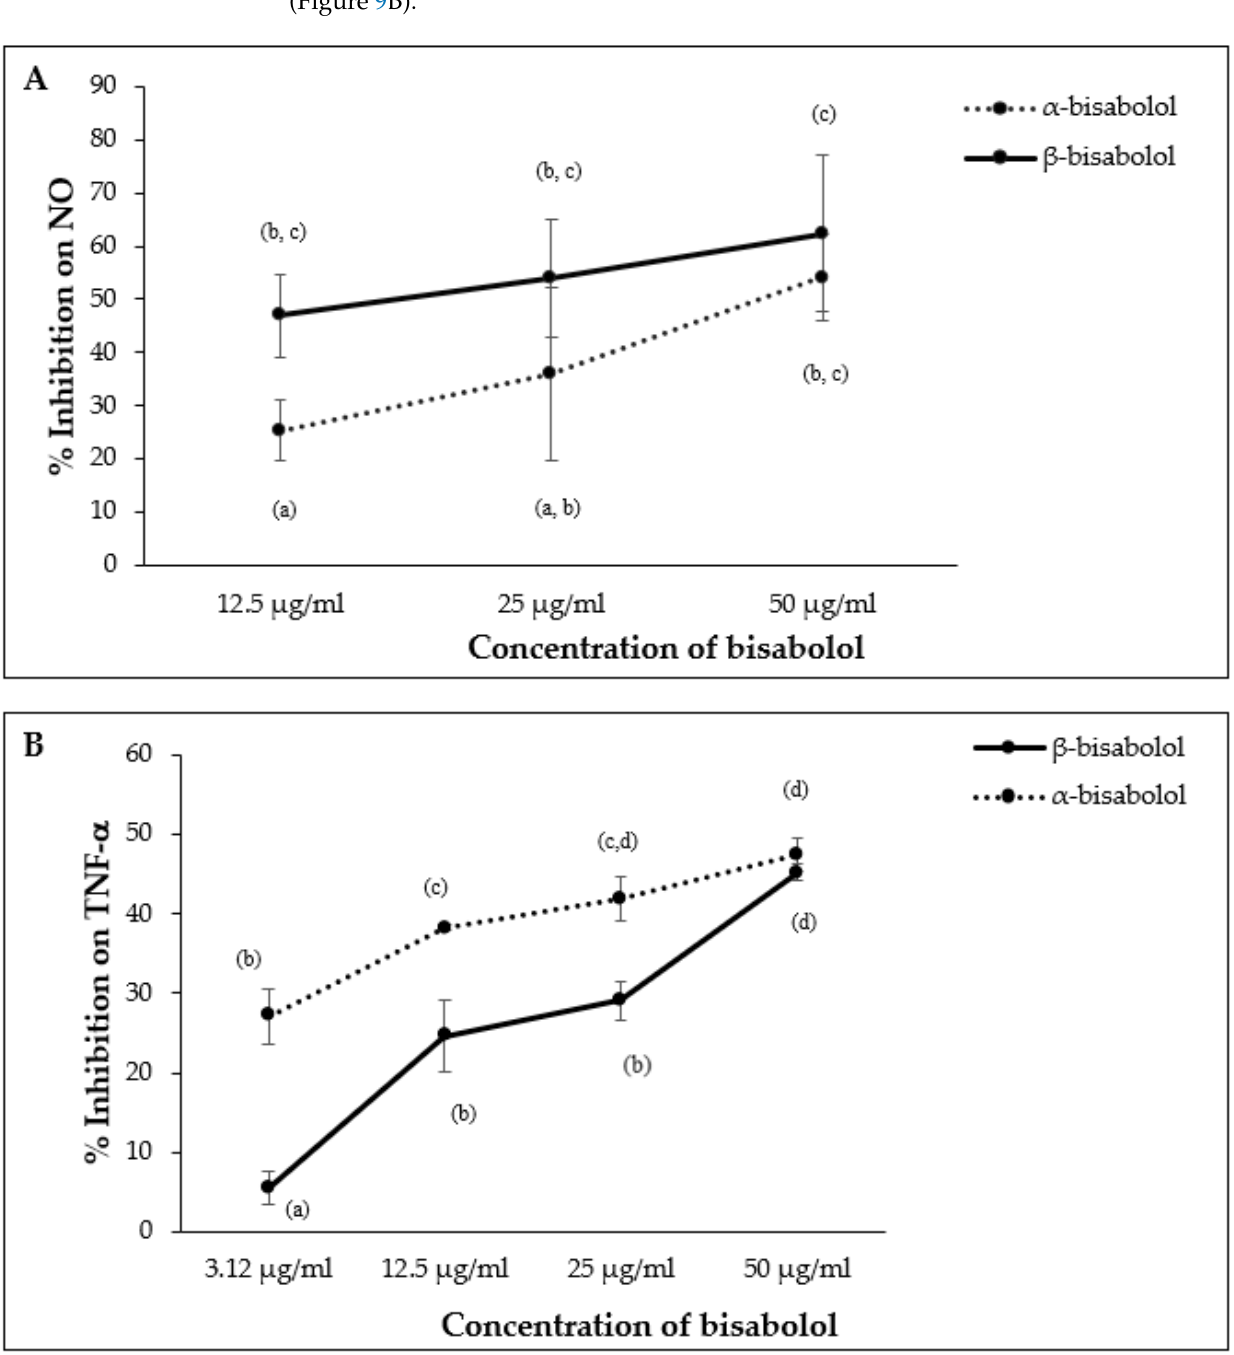
Figure 9. Effect of α -bisabolol and β -bisabolol dilutions on NO ( A ) and TNF- α ( B ) production in RAW 264.7 cells . RAW 264.7 cells were exposed to test extracts or compounds for 1 h and then induced with 100 ng/mL lipopolysaccharide (LPS) for NO and TNF- α production ( n = 3). Values are expressed as mean ± SD. Duncan’s multiple range test between average TNF- α and NO production across the different concentrations indicates that dissimilar letters/numerals denote a significant difference ( p ≤ 0.05).